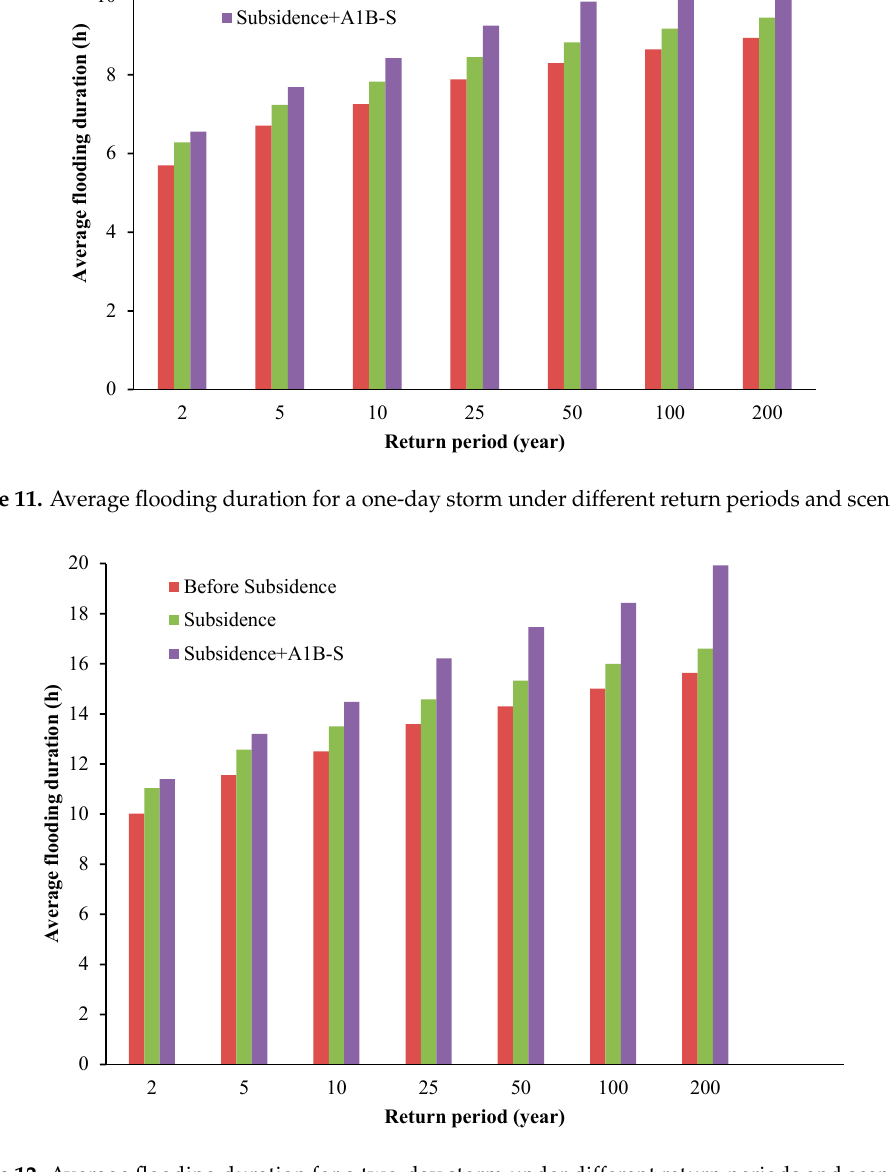
Figure 12. Average flooding duration for a two-day storm under different return periods and scenarios.